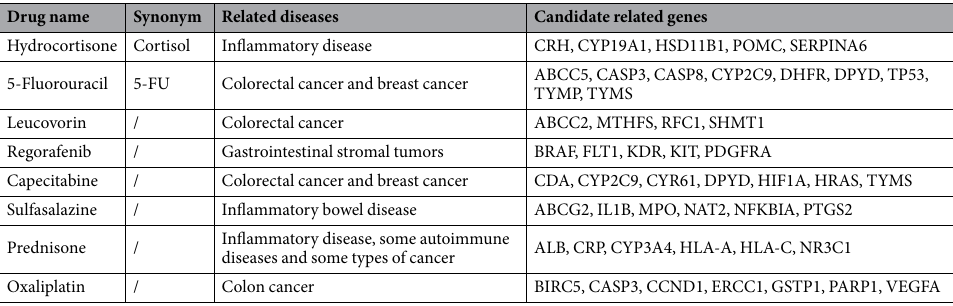
Table 2. Eight drugs used for intestinal diseases. The drug names of 5-Fluorouracil and Hydrocortisone could not be searched in database, the synonyms of these drugs were